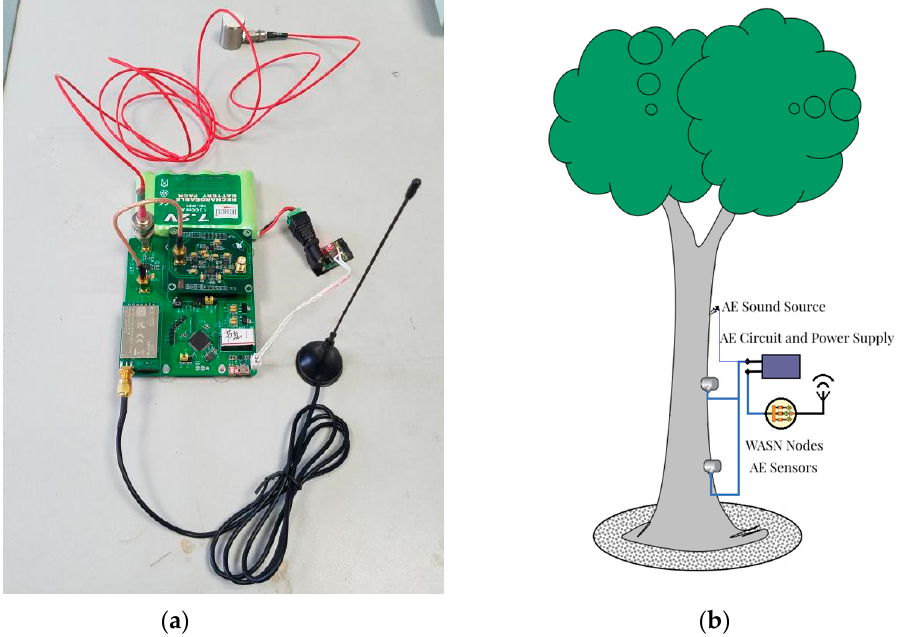
Figure 3. Sample wireless AE node and its installation measurement schematic. ( a ) Sample wireless AE node; ( b ) its installation measurement schematic.